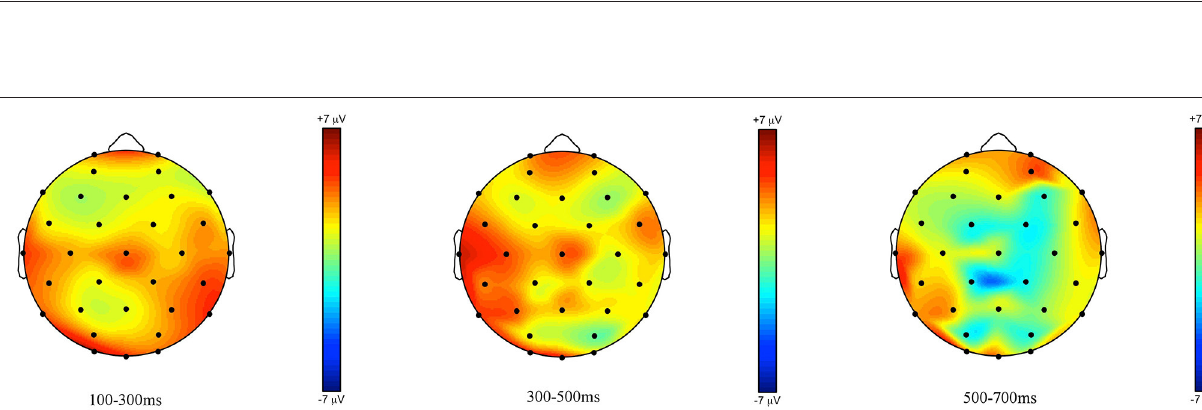
Frontiers in Psychology | www.frontiersin.org